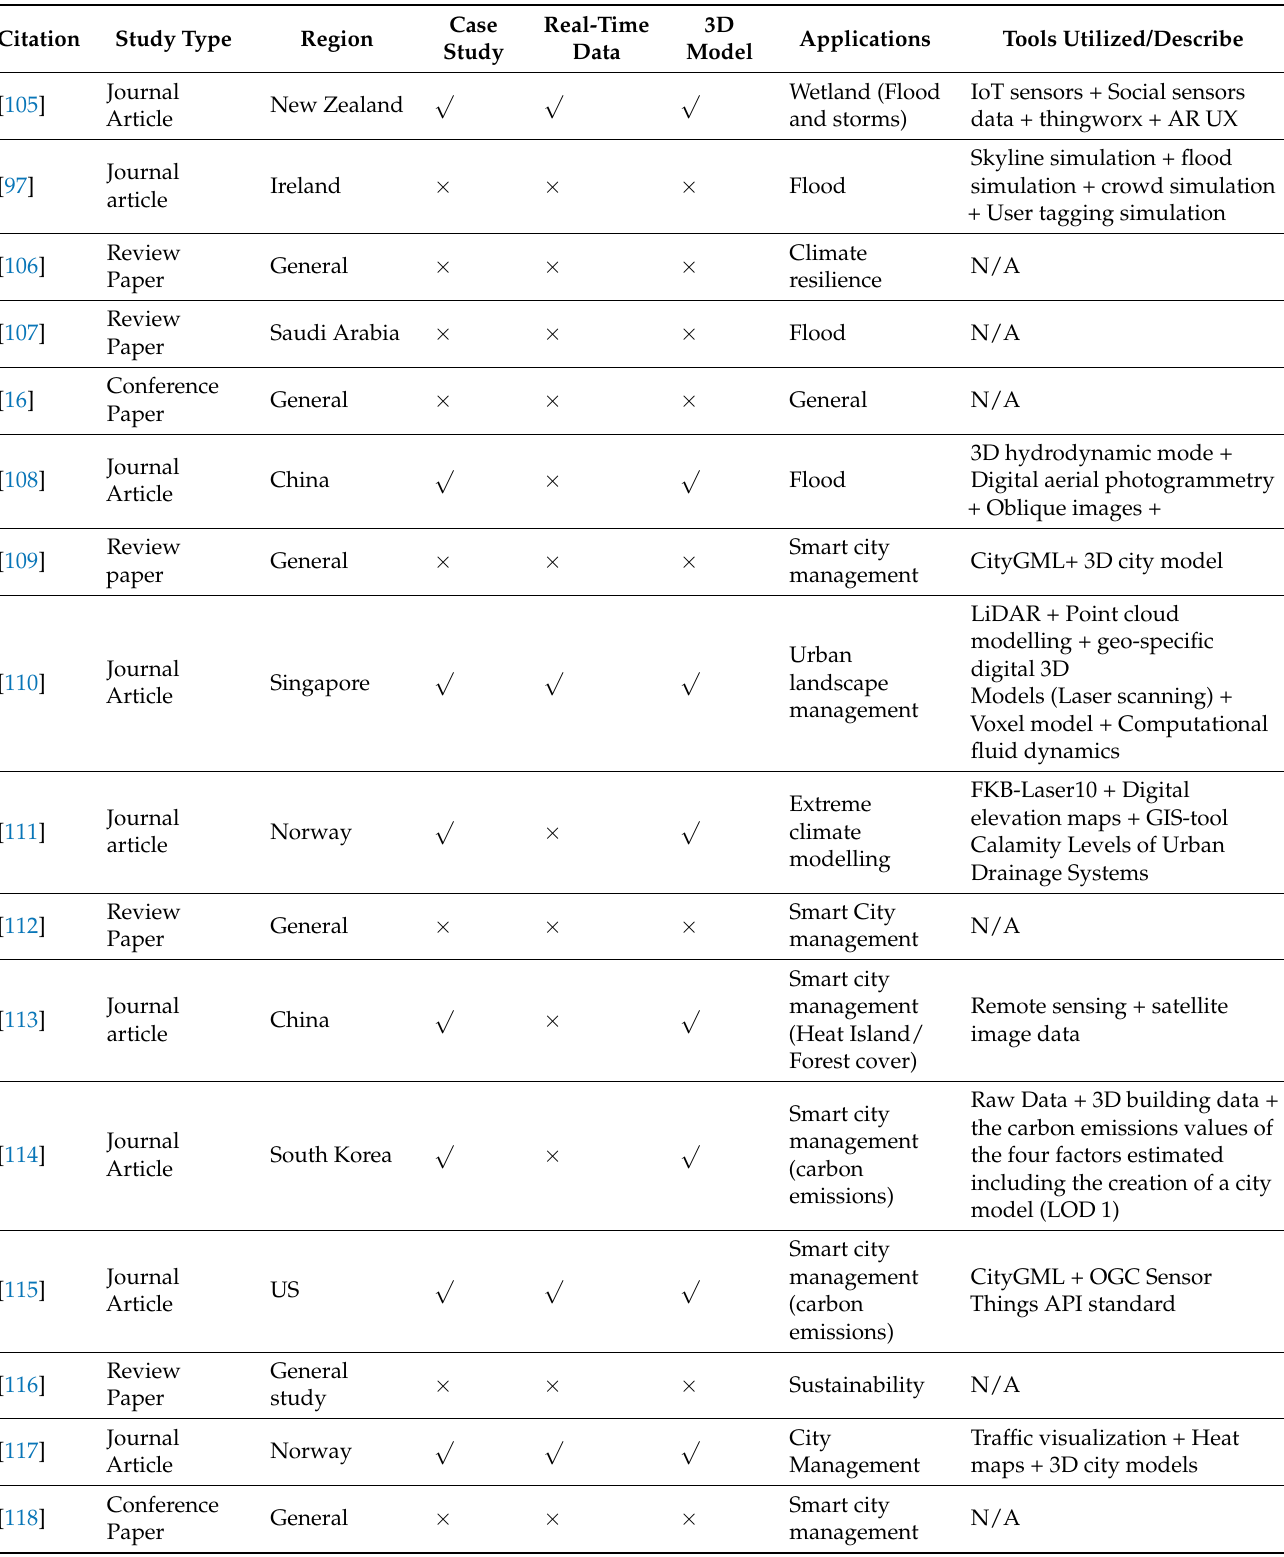
Table 4. List of eligible digital twin articles included in the review with their research objectives and other